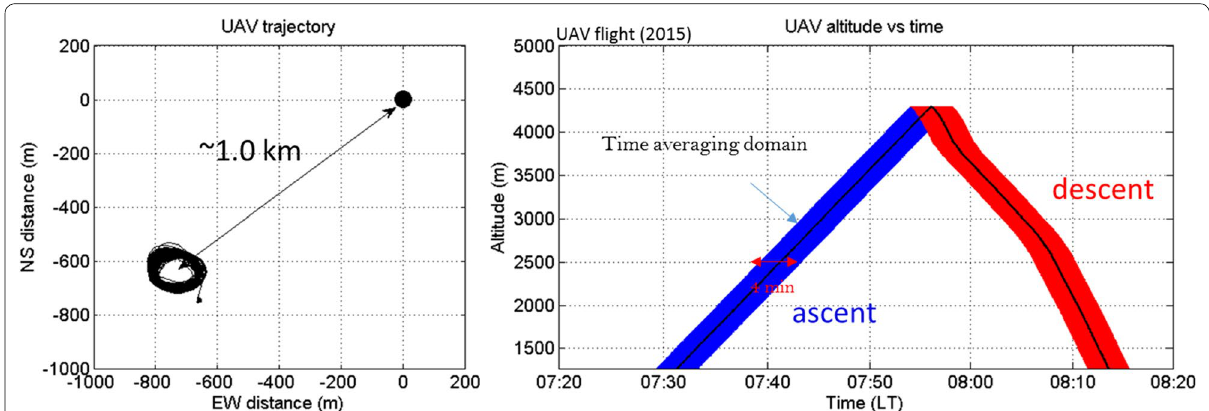
Fig. 1 Schematic representation of the method used for estimating pseudo-vertical profiles of Doppler variances σ 2 from radar data. (Left) Example of horizontal excursion of a UAV with respect to MU radar antenna array location (black dot). (Right) The corresponding UAV altitude versus time (black line). The blue and red areas indicate the time-height domain used for calculating the average of Doppler variances σ 2 during the ascent and descent of the UAV, respectively. Time averaging for a given altitude was arbitrarily performed over 4 min centered at the time when the UAV reached this altitude